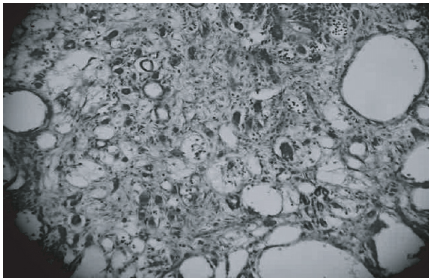
Figure 2. Massive tubular dilation accompanied with flattening and necrosis of tubular epithelial cells in kidney of rat chroni- cally treated with CDDP. HE 250X.